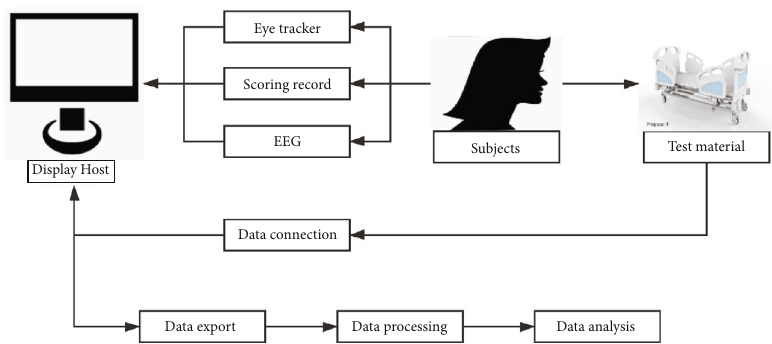
Figure 3: Experimental data acquisition